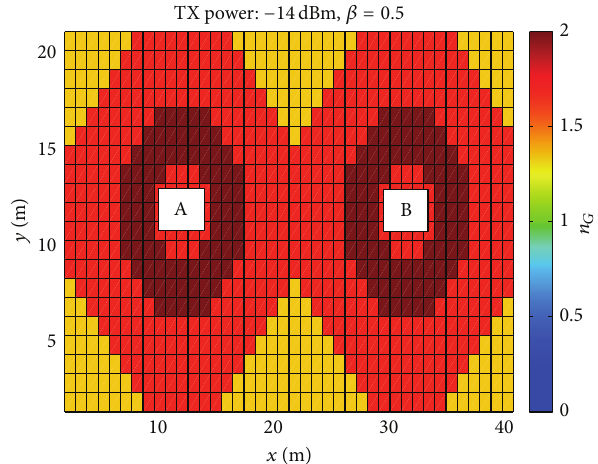
Figure 8: Performance of 2 × 2 i-MIMO DAS in a 2D deployment case. Relative gain with respect to SISO is shown (RAU antenna power: − 14dBm; 𝛽 = 0.5; RAU antenna distance: 20